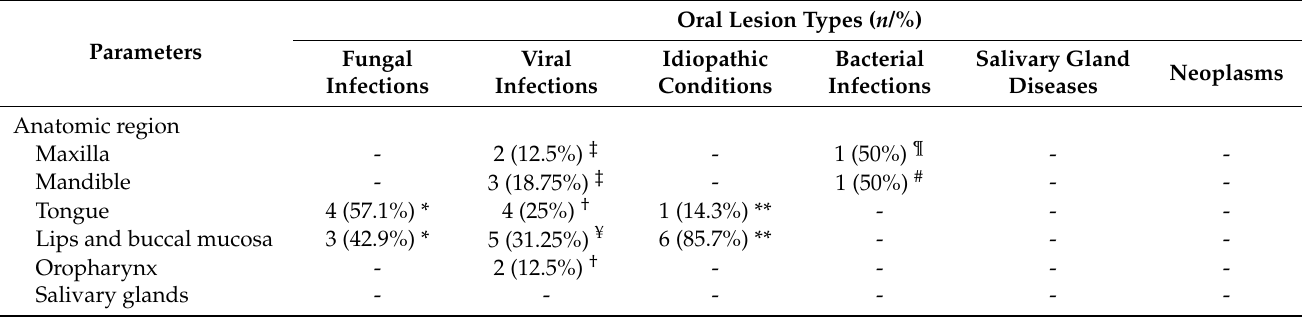
Table 2. Frequency of oral lesion type per group.